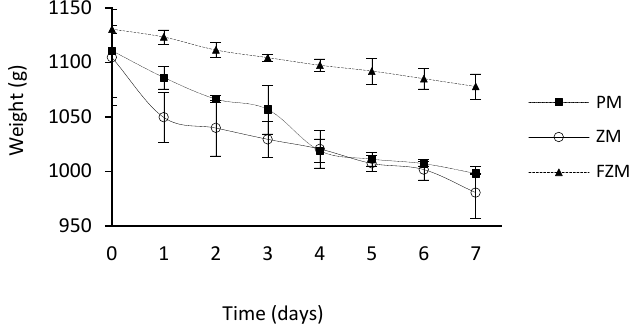
Figure 3. Weight loss of the acidic solution for each membrane type (experiment 1).